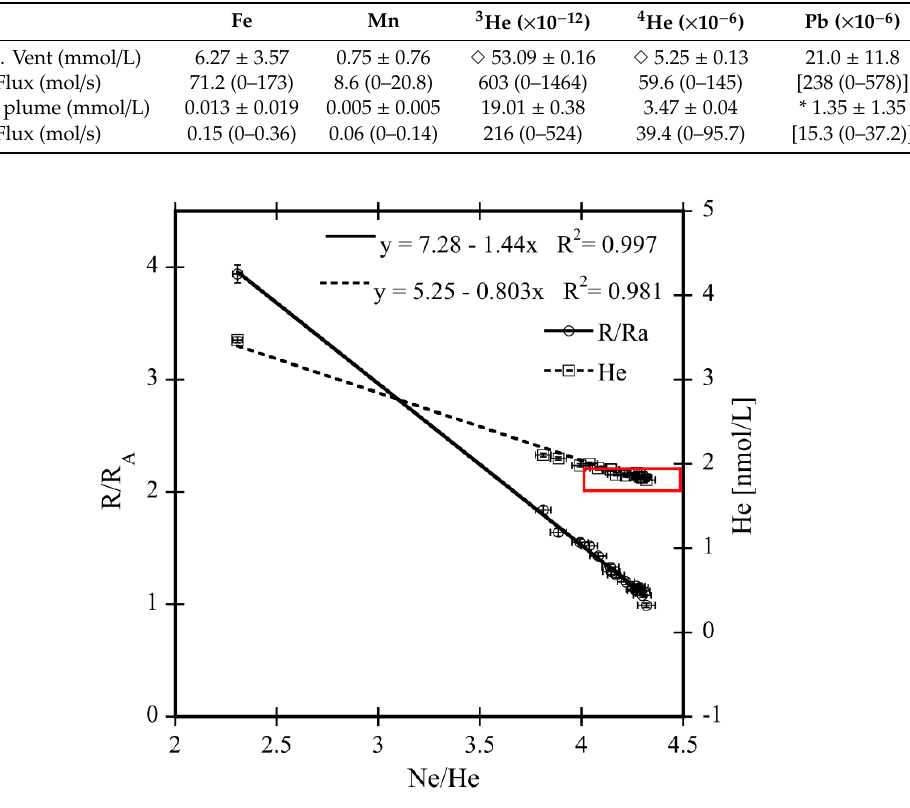
Figure 6. He isotope ratio to atmospheric He isotope ratio (R / R A ) and total helium concentrations of hydrothermal plume samples from Brothers volcano plotted against the Ne / He ratio. The linear trends were extrapolated to calculate the 3 He and 4 He concentration in the end member fluid at Ne / He = 0. The average Pacific deep water He concentration and Ne / He ratio is marked with a red frame; averages were taken from Ozima and Podosek [81]. Please note that errors are within the range of the symbol size.